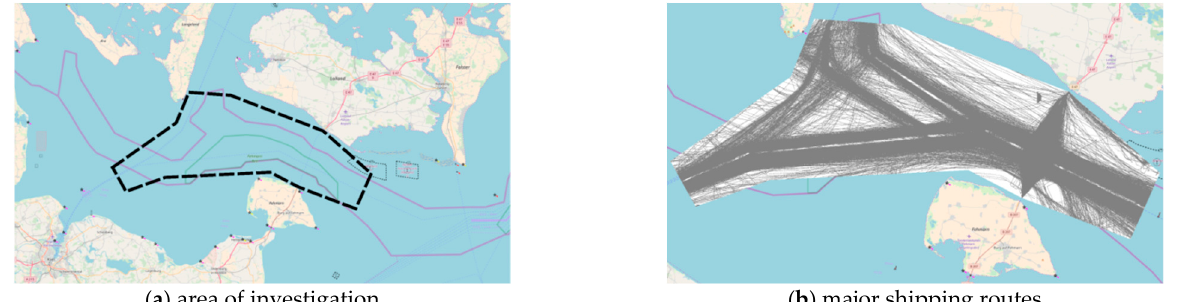
Figure 2. Database: ( a ) the polygon defining the area for the automatic identification system (AIS) data analysis and ( b ) the major shipping routes derived from AIS data.